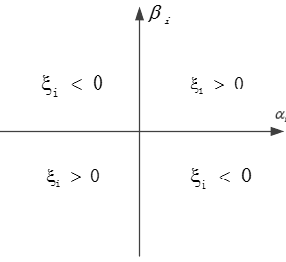
Figure 2. The position of ξ i in coordination.